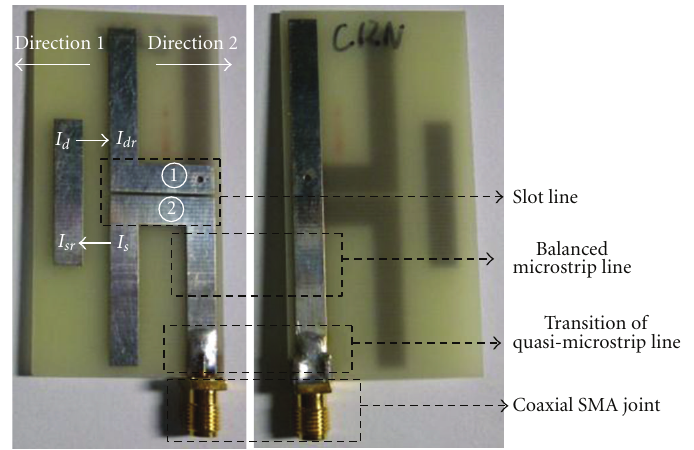
Figure 4: Feeding structure of the proposed printed Yagi-Uda antenna unit.